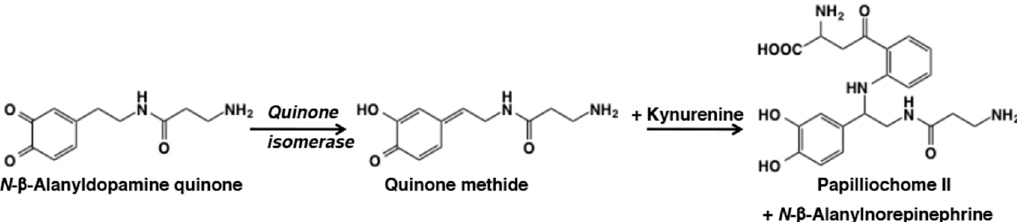
Figure 20. Reaction of N - β -alanyldopamine quinone with kynurenine to form papilliochrome II [99–101]. Note that quinone isomerase was required for the production of papilliochrome II and that N - β -alanylnorepinephrine was also produced through addition of water.